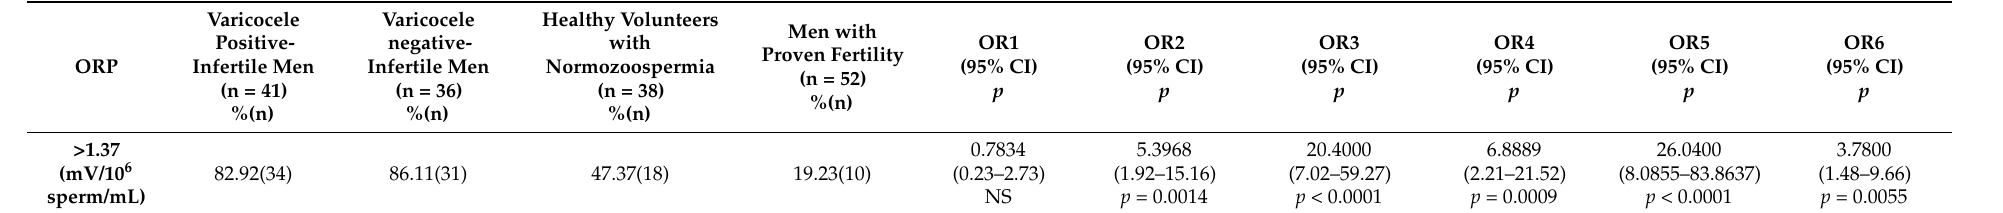
Table 5. Odds ratio for high ORP in study